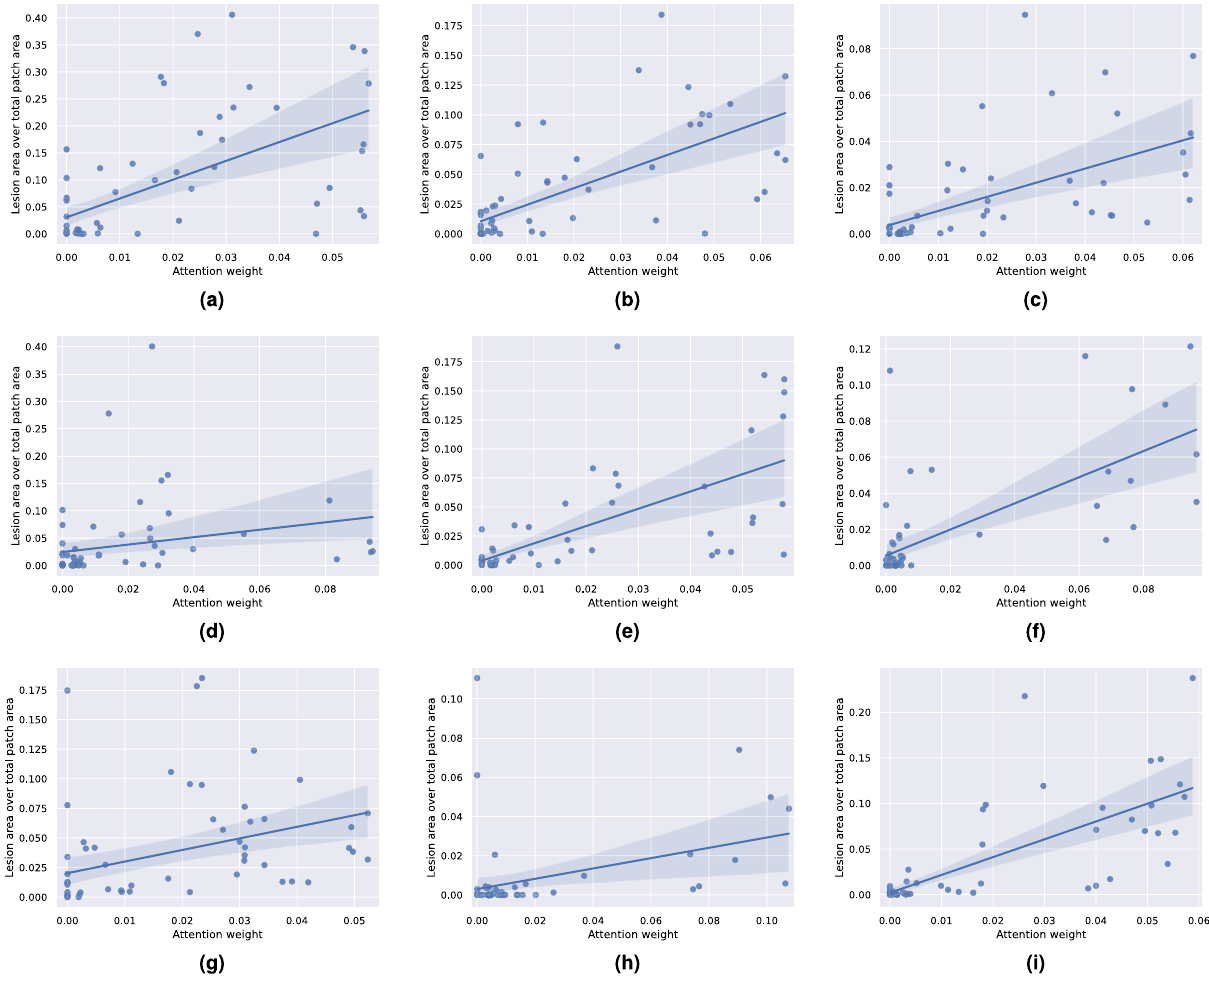
Figure 8. Example scatterplots of the attention weight assigned by the model to each patch versus the percentage of the patch area that contains lesions. The plots are computed using images from the IDRiD dataset, for which detailed per-pixel lesion annotations for microaneurysms, haemorrhages, soft and hard exudates are available. A linear regression fit is estimated for each image and overlayed on the plot to highlight the linear